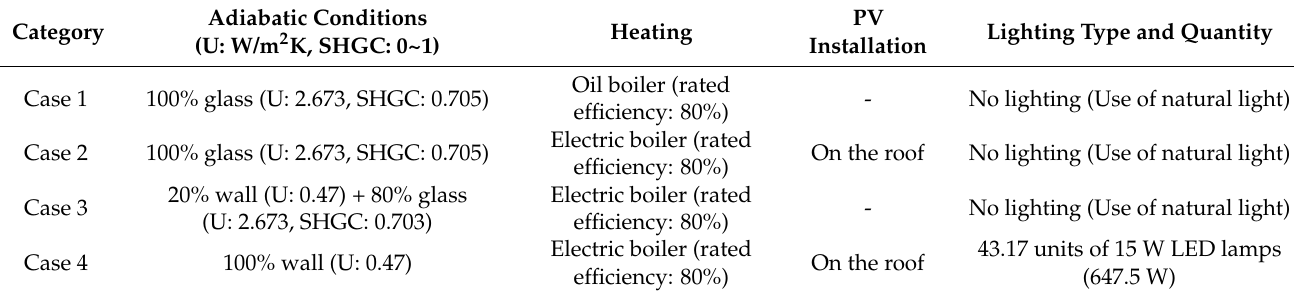
Figure 2. Model schematic diagram of different cases. Table 3. Case study conditions.